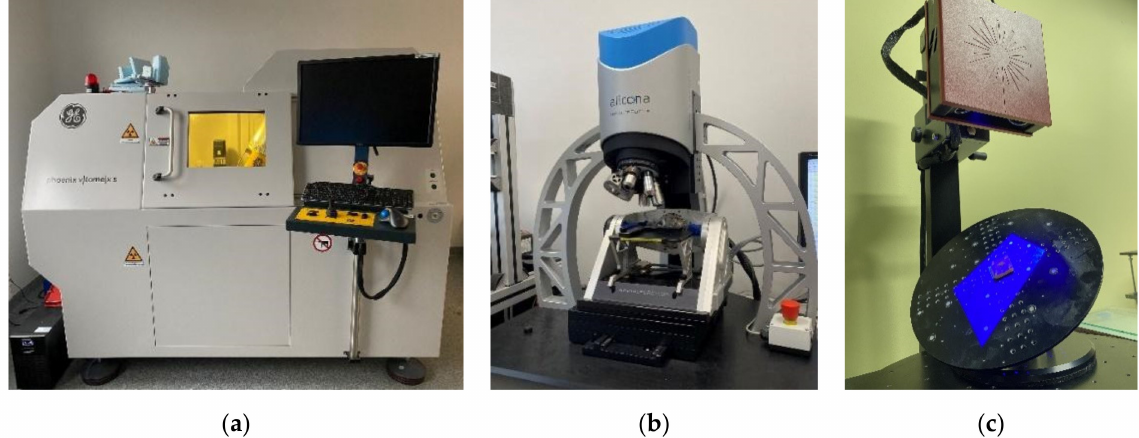
Figure 4. Measurement devices used in the study: ( a ) X-ray CT; ( b ) focus variation microscope; ( c ) structured blue-light